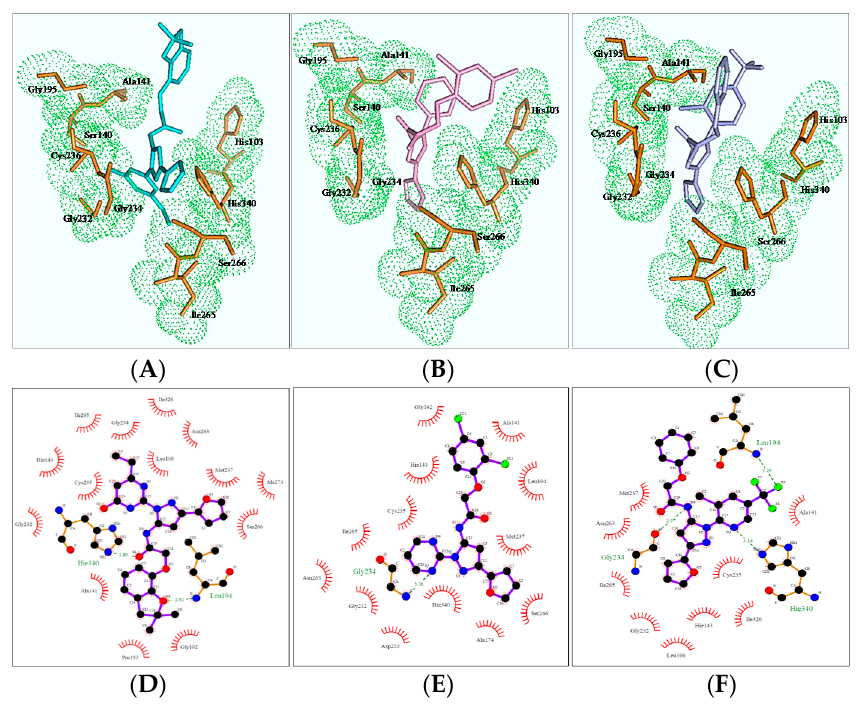
Figure 2. Binding mode of ZINC12007063 ( A , D ), 4u ( B , E ) and 8h ( C , F ).